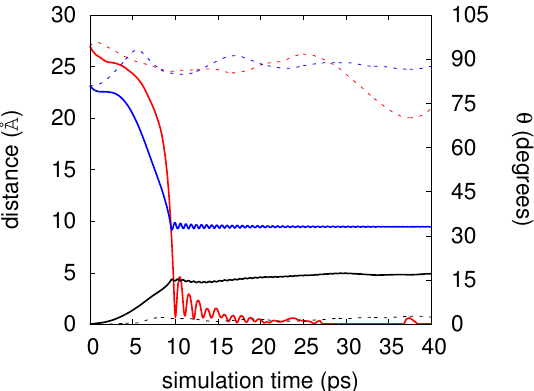
Figure 8. For M = 10, evolution of relative Cs 2 -C 60 distance, R and orientation, θ , as function of time. Dashed lines correspond to an initial velocity v 0 = 25.4 m/s, while solid lines show simulation starting with v 0 = 239.8 m/s. Blue lines: relative distance between two reactants; red lines: relative orientation; black lines: distance from C 60 to its original position at time